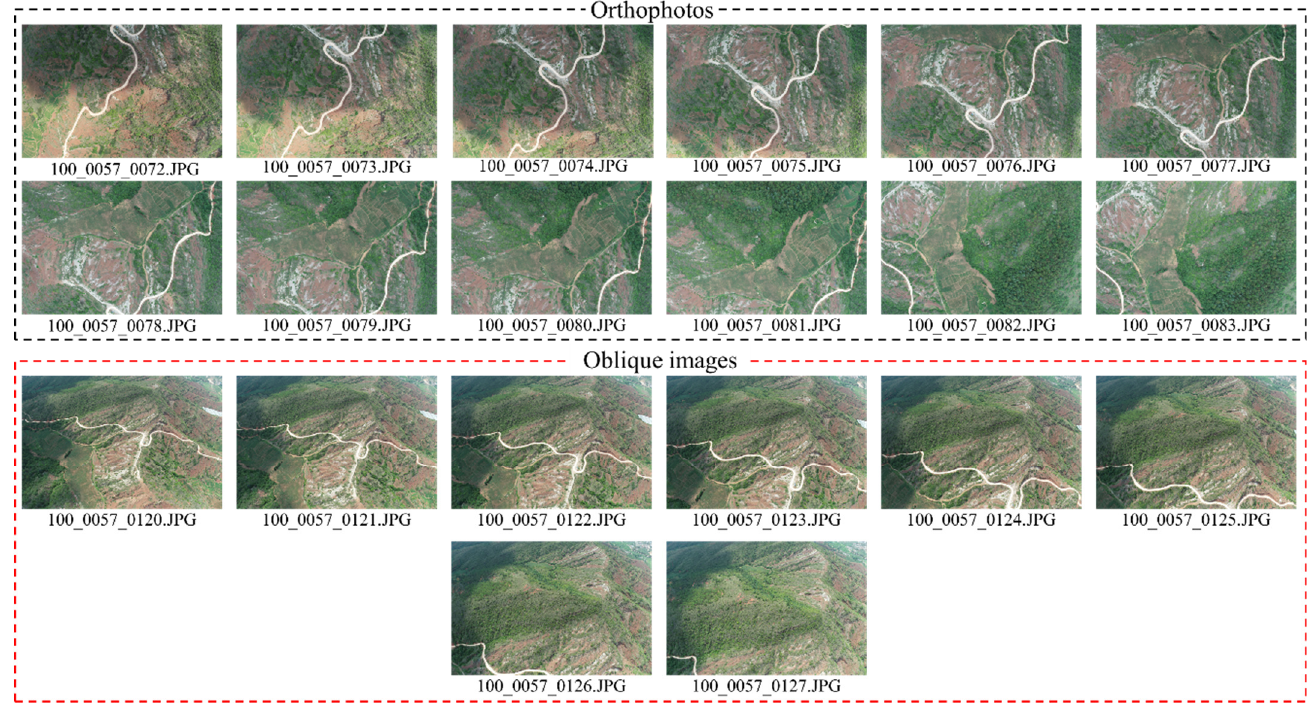
Figure 2. Partial orthophotos and oblique images ( 80%_𝑅1_𝑂1 dataset as an example). 142 Table 3. Characteristics of datasets resulting from the test setup.